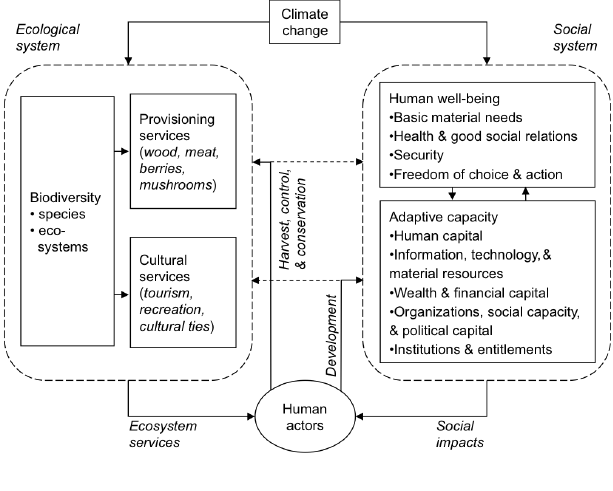
Fig. 2 . Conceptual model used in the analyses, consisting of an ecological system of natural or seminatural ecosystems providing ecosystem goods and services to human actors, made possible by the biodiversity at the level of species and ecosystems, and a social system, represented by determinants of human well-being and societal adaptive capacity, affecting the vulnerability or resilience of human actors. The determinants of adaptive capacity are relevant at a hierarchy of scales nested within each other, going from global to local communities and individual households. Human actors manage ecosystems by harvest, control measures and conservation strategies (solid arrows), having side-effects on adaptive capacity (dashed arrows), and develop or affect societal adaptive capacity by various activities and decisions, having side-effects on ecosystems. Adapted from Millennium Ecosystem Assessment (2003), Chapin et al. (2006), and Eakin and Lemos (2006).